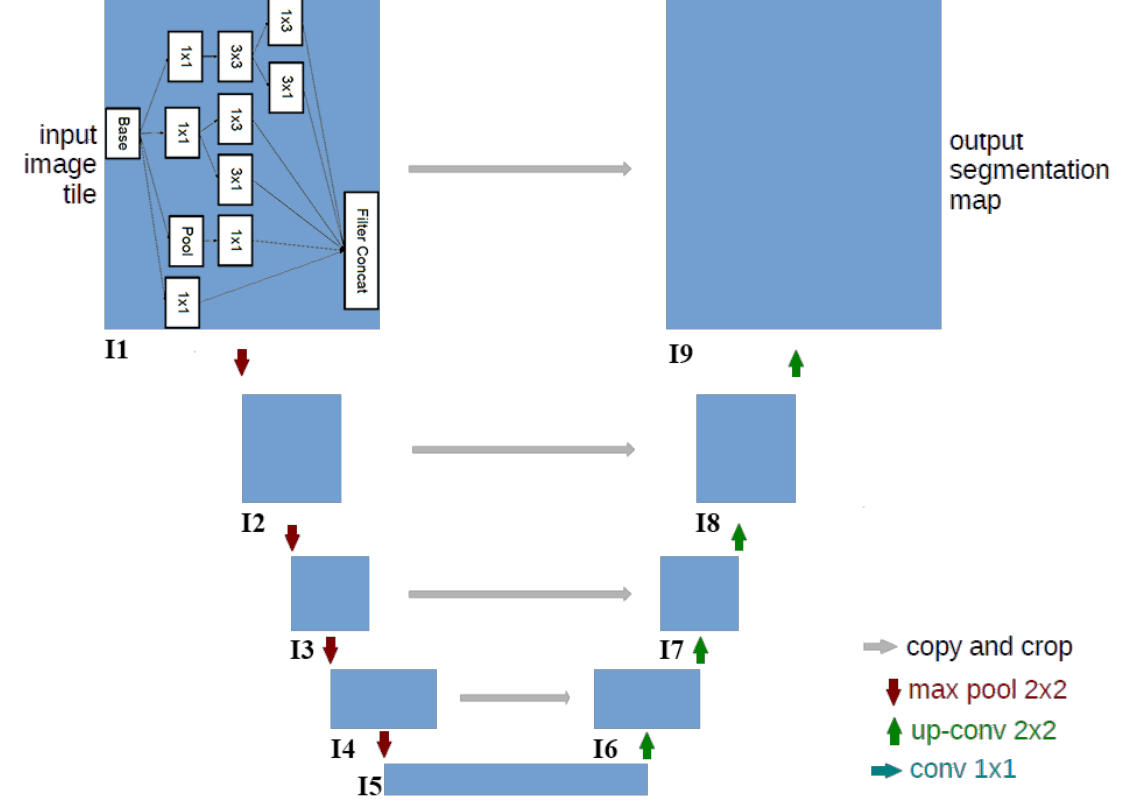
Figure 3. Segmentation-network